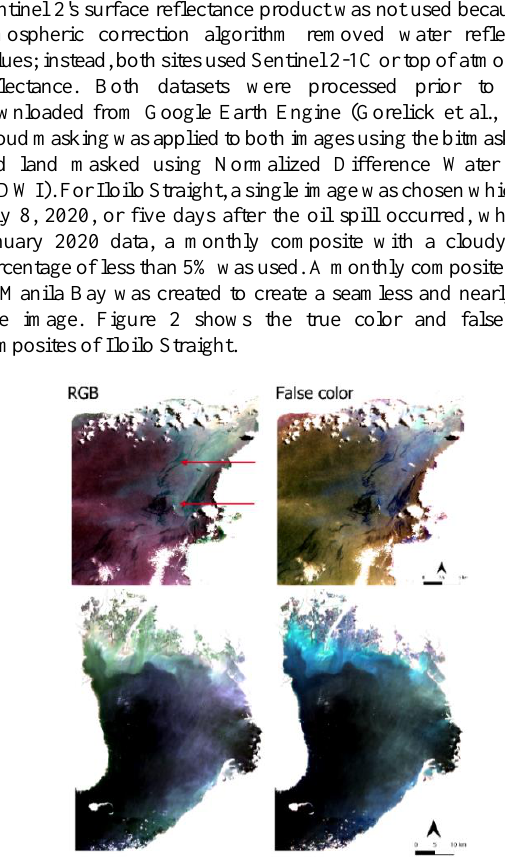
Figure 2. Sentinel-2 true color (left) and false color composite (right) of Iloilo straight (top) and Manila Bay (bottom). The arrows indicate oil-contaminated water because of the large